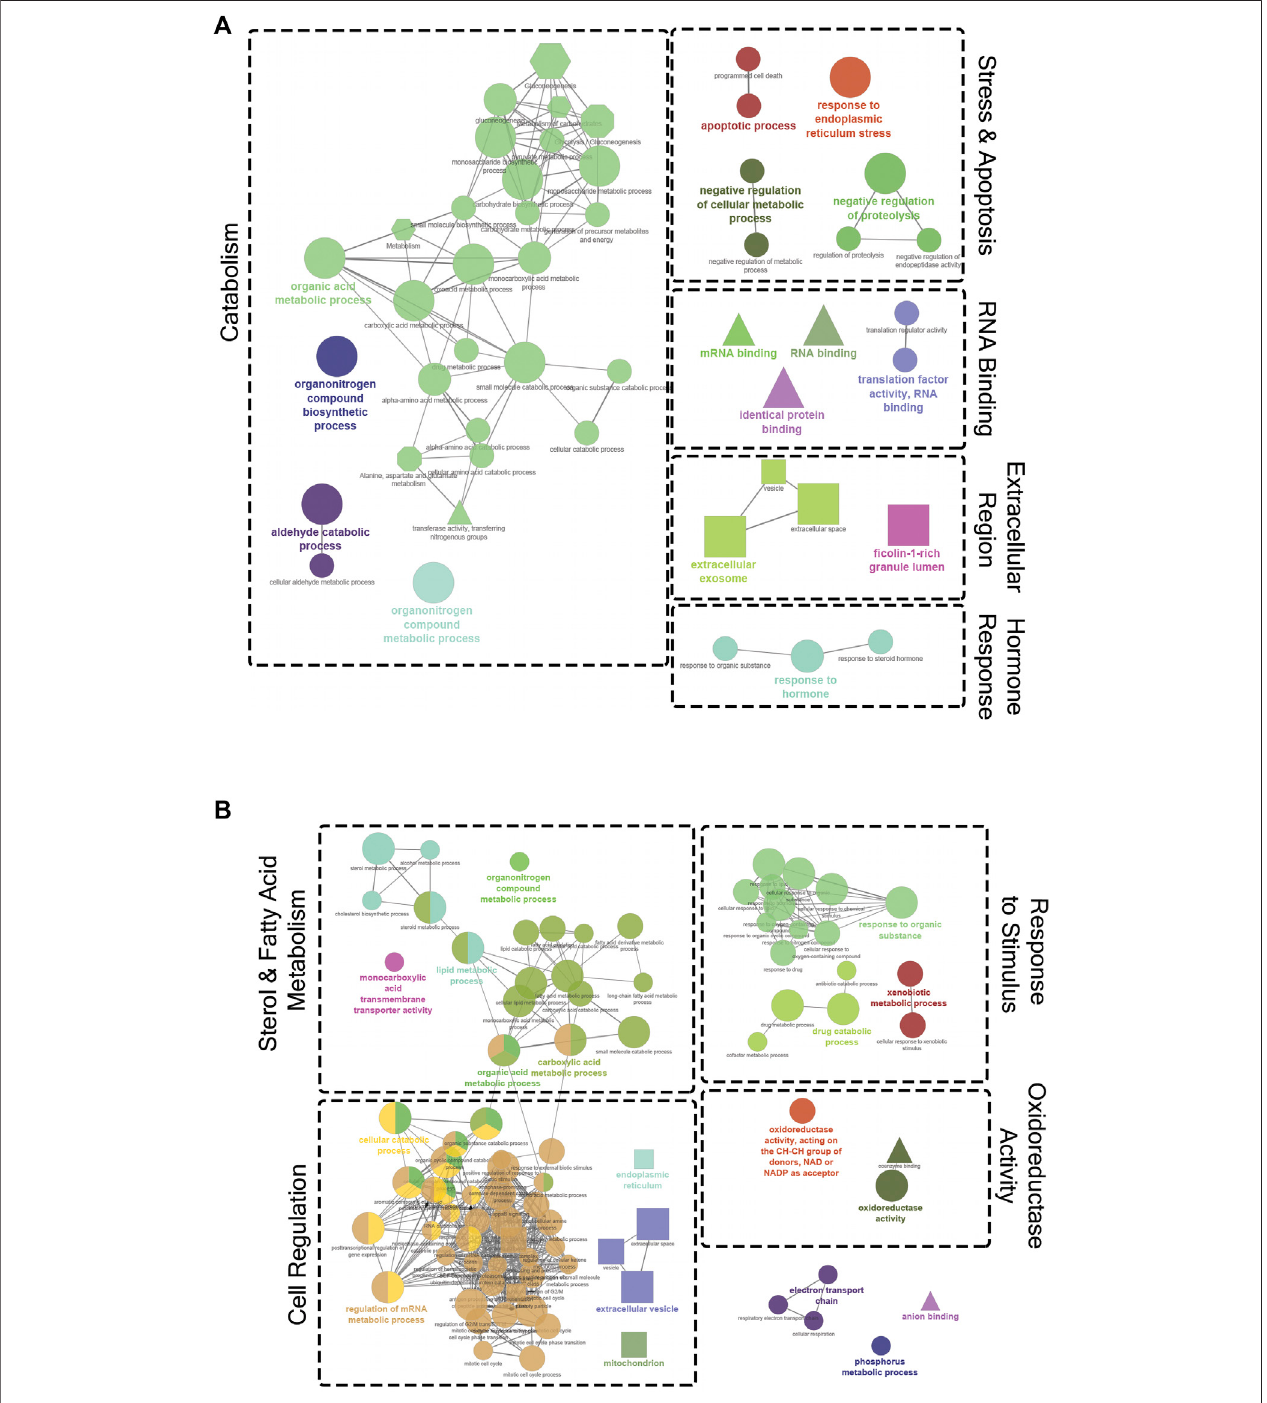
FIGURE 4 | Gene ontology (GO) term enrichment and pathway network analysis of signi fi cantly differentially expressed transcripts(DETs) between the 10.5 ° C and 16.5 ° C groups. (A) Downregulated DETs at 10.5 ° C (659 DETs). (B) Upregulated DETs at 10.5 ° C (718 DETs). Only signi fi cant ( p < 0.05) network terms were included in the visualization. The diameter of each node indicates the level of signi fi cance for that speci fi c term, with a larger node corresponding to a lower p -value. Node colour signi fi es related processes that share similar DETs. The shape of the node re fl ects the database where the term originated (circle, GO Biological Process; triangle, GO Molecular Function; square, GO Cellular Component; hexagon, Reactome). Dotted borders and labels were used to group related clusters and highlight general themes.